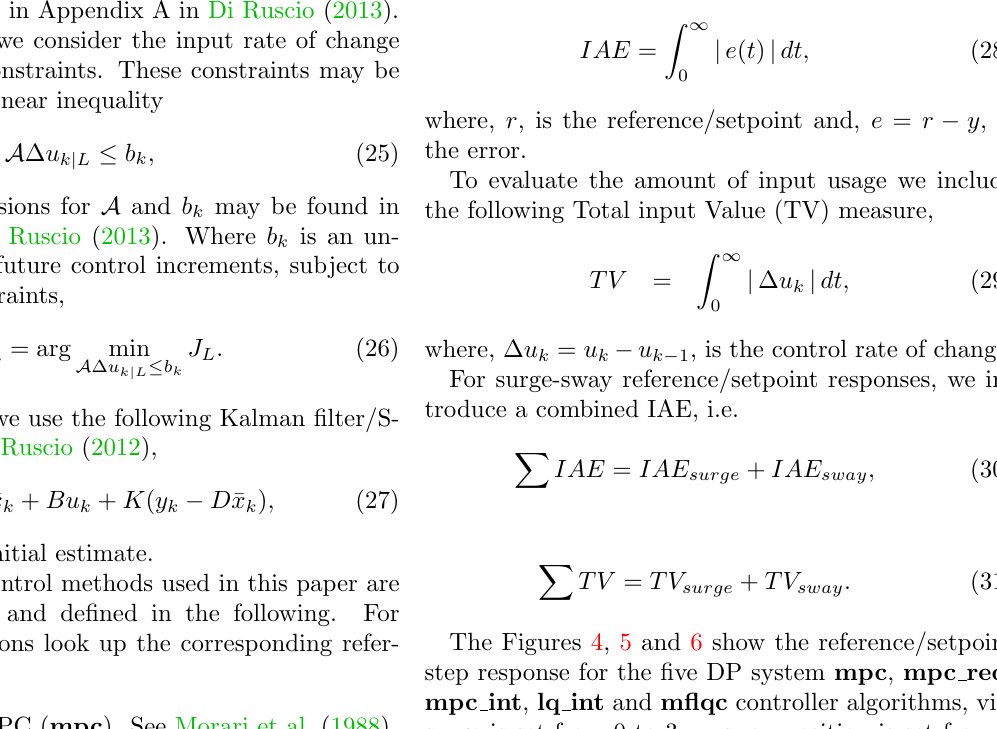
Table 3 (rows 2:6, column 2), the mpc int algorithm is seen to